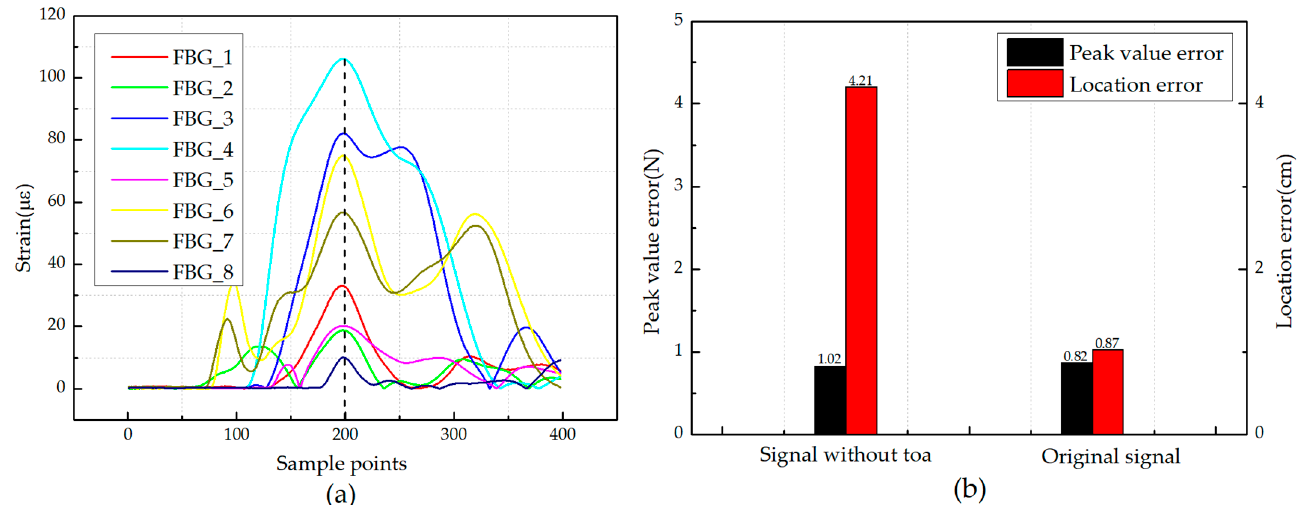
Figure 17. ( a ) Strain responses of different FBG sensors without the information of ToA; ( b ) comparison of impact identification results based on data without ToA and basic